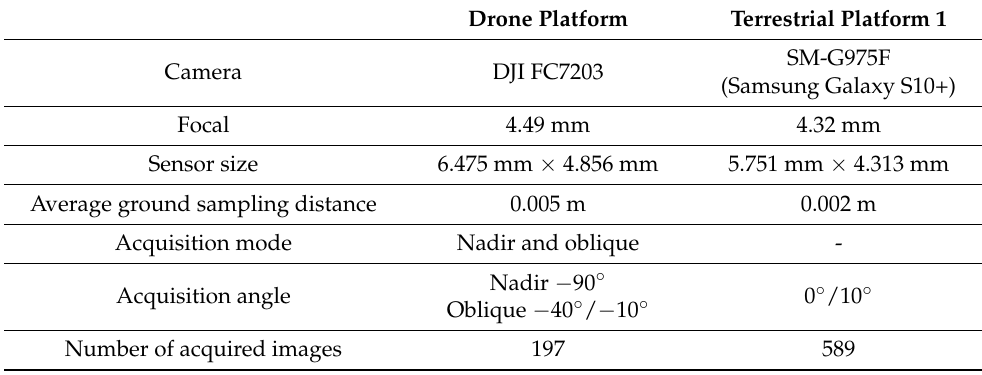
Table 1. Church exterior acquisition parameters for the drone and the terrestrial